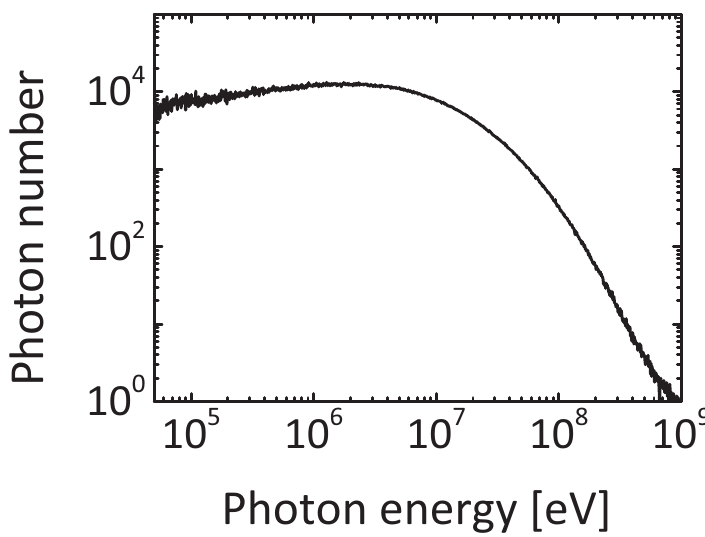
Figure 1. An example of the energy spectrum of γ -rays generated predominantly by the radiation effect. Above 10 7 eV, the γ -ray flux decreases as photon energy increases, whereas the peak is located at 1–3 MeV.